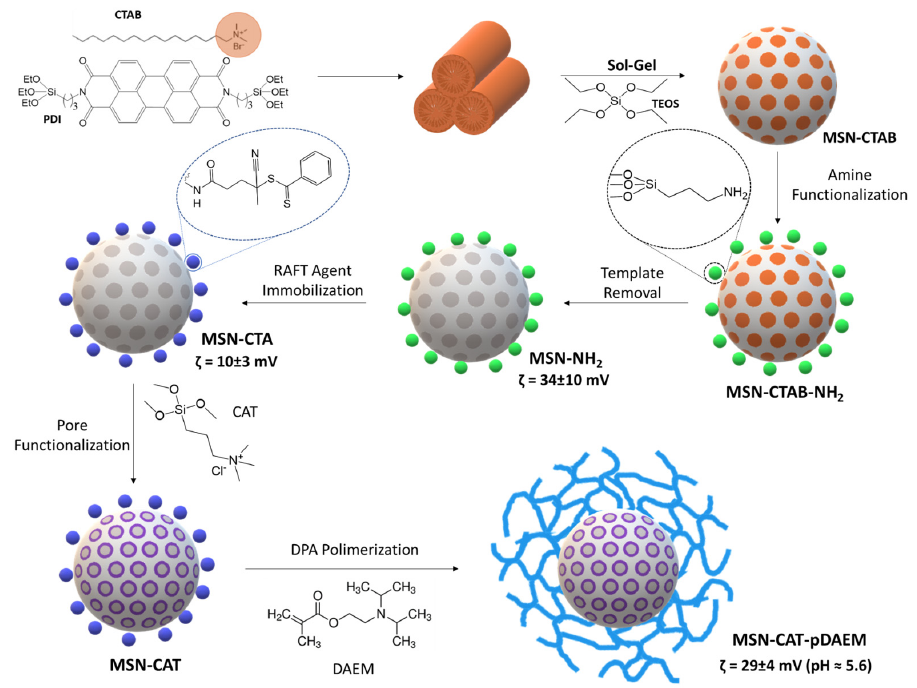
Figure 1. Preparation of hybrid fluorescent core-shell MSNs with functionalized pores and a pH- responsive polymer shell. The fluorescent dye (PDI) is anchored to the silica structure (MSN-CTAB), which is then surface-modified with amine groups (MSN-CTAB-NH 2 ). After template removal (MSN-NH 2 ), a RAFT CTA is immobilized in the surface by reaction with the amine groups. The free pores are then functionalized with a cationic group, and the CTA is used to polymerize the shell by RAFT. Zeta-potential values measured at pH = 5.6 reflect the change in surface charge upon surface modification.